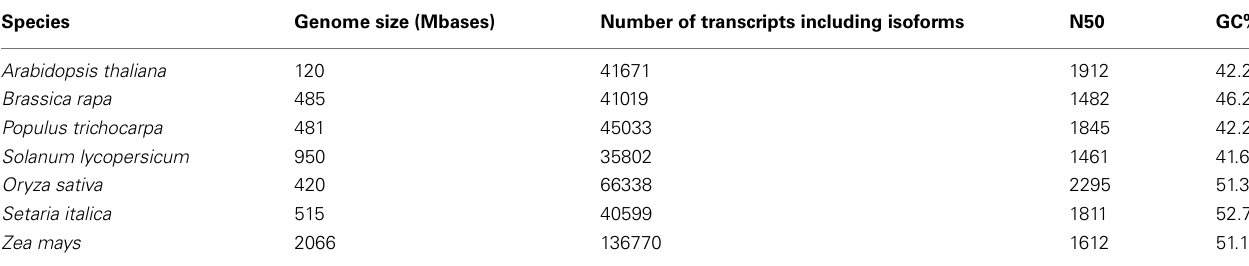
Table 2 | Quality assessment parameters drawn from transcripts of publicly available genome